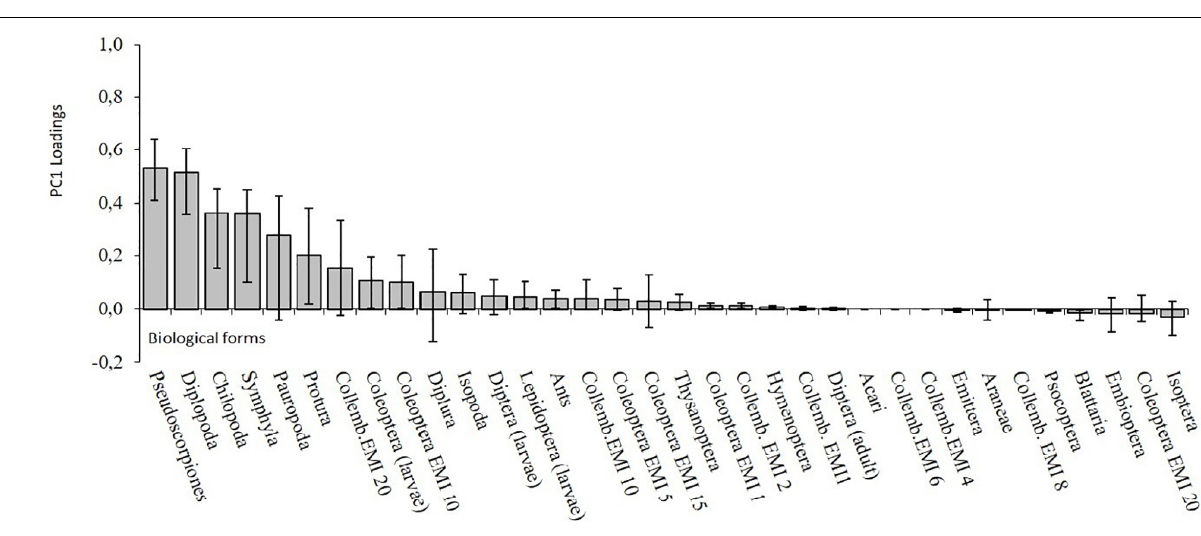
FIGURE 6 | PC1 factor loadings. The line represents the 95% bootstrap confidential interval of coefficient